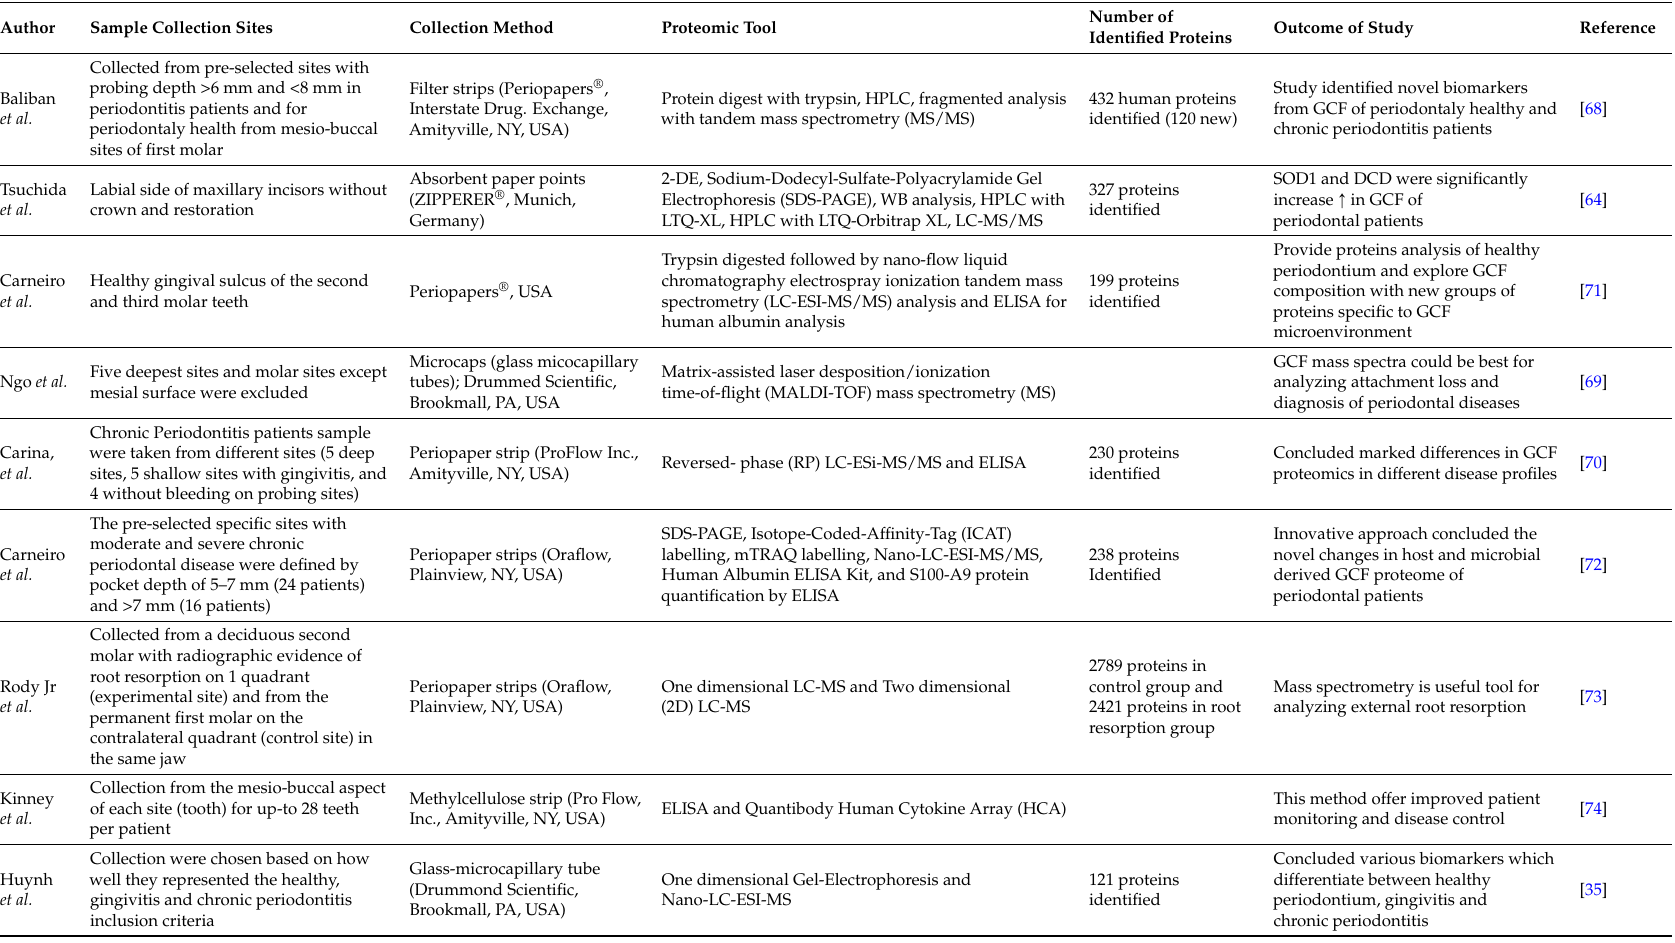
Table 2. Profiling and proteomic tools used for the detection and characterization of gingival crevicular fluid (GCF)